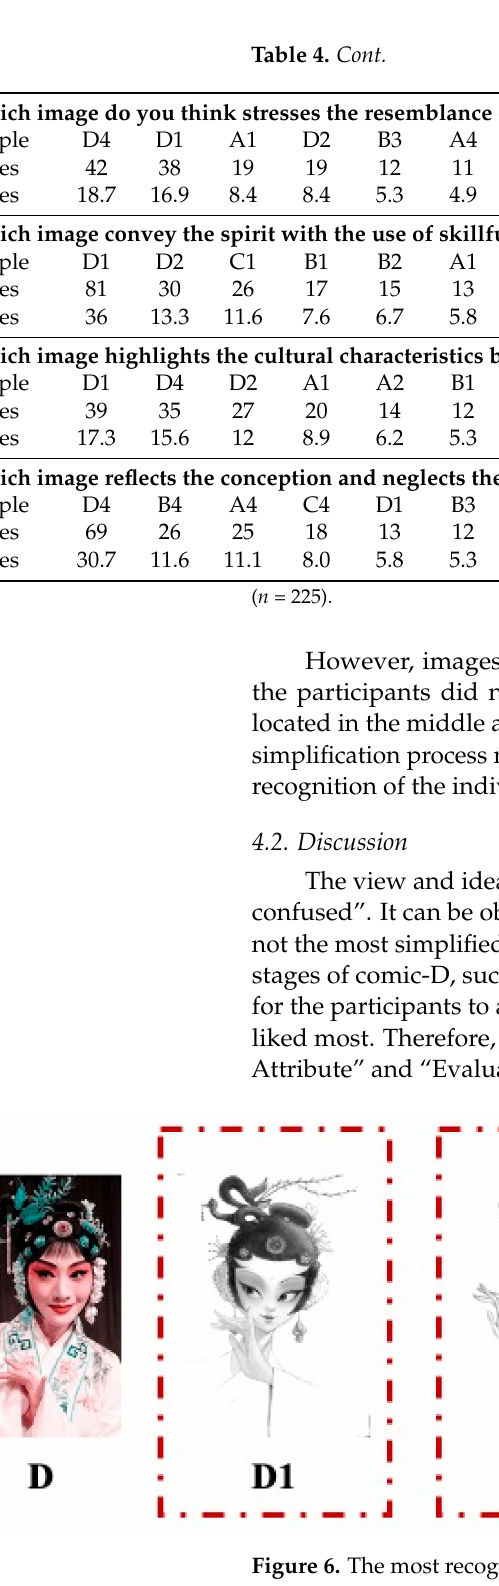
Figure 6. The most recognized sample in evaluation of preferences (Source: this